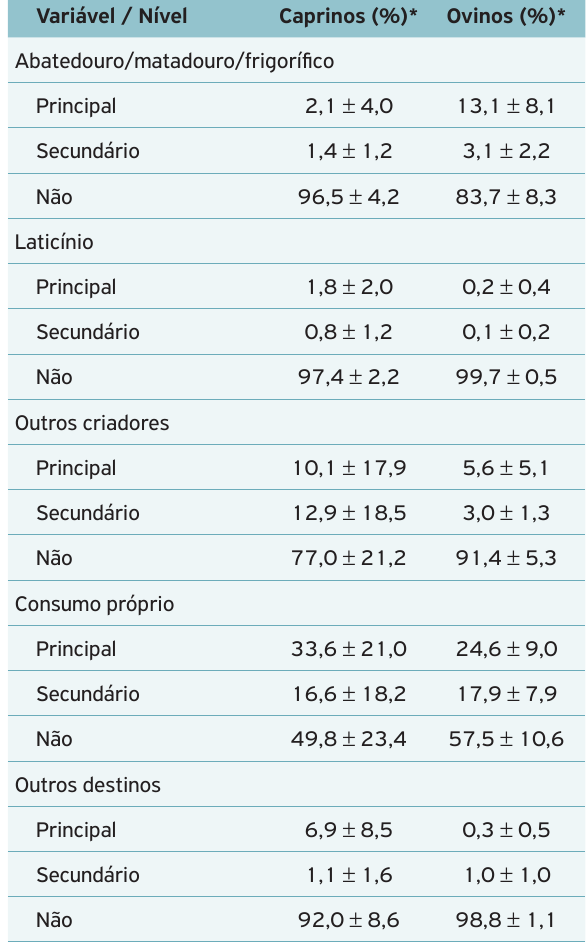
Tabela 6. Caprinocultura e ovinocultura: destino da produção, estado de São Paulo,